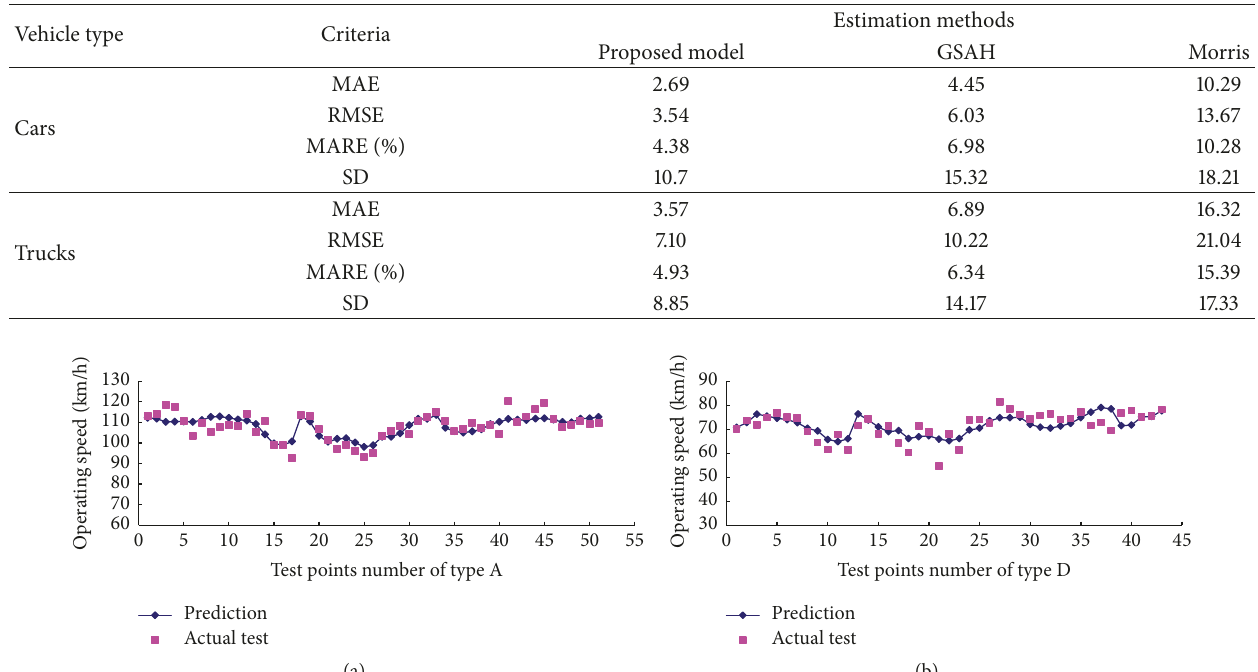
Table 4: Comparison results of three models.